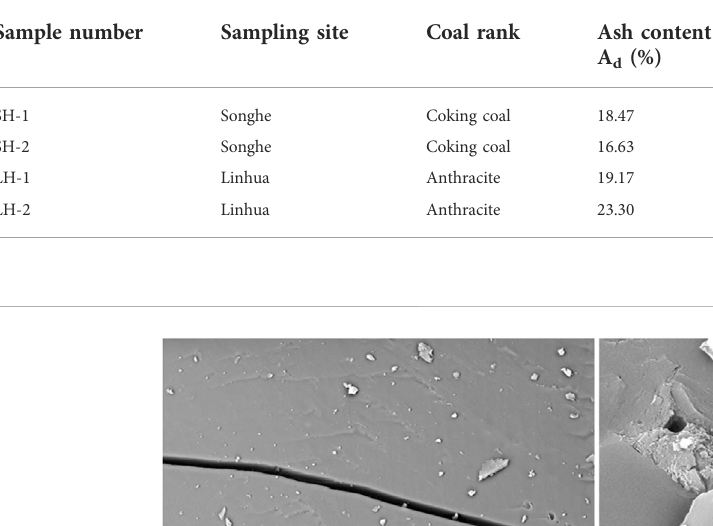
TABLE 1 Basic information on coal samples.